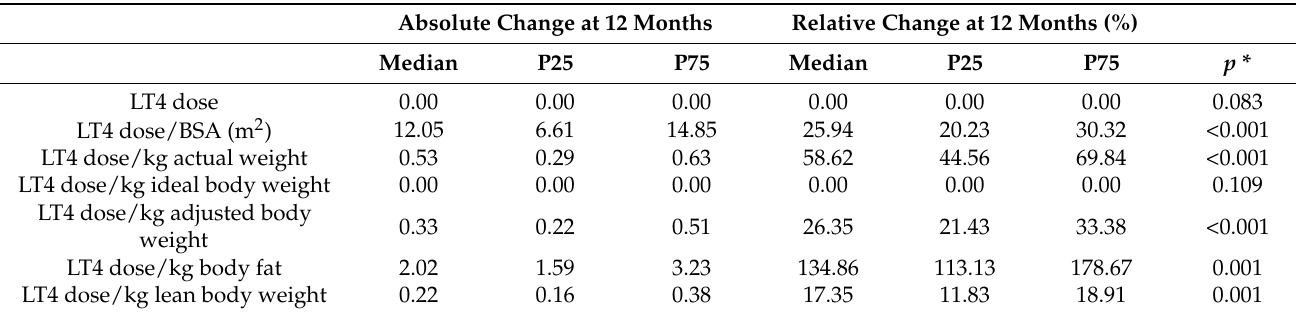
Table 4. Absolute and relative levothyroxine (LT4) dose change in hypothyroid patients before and twelve months after bariatric surgery.